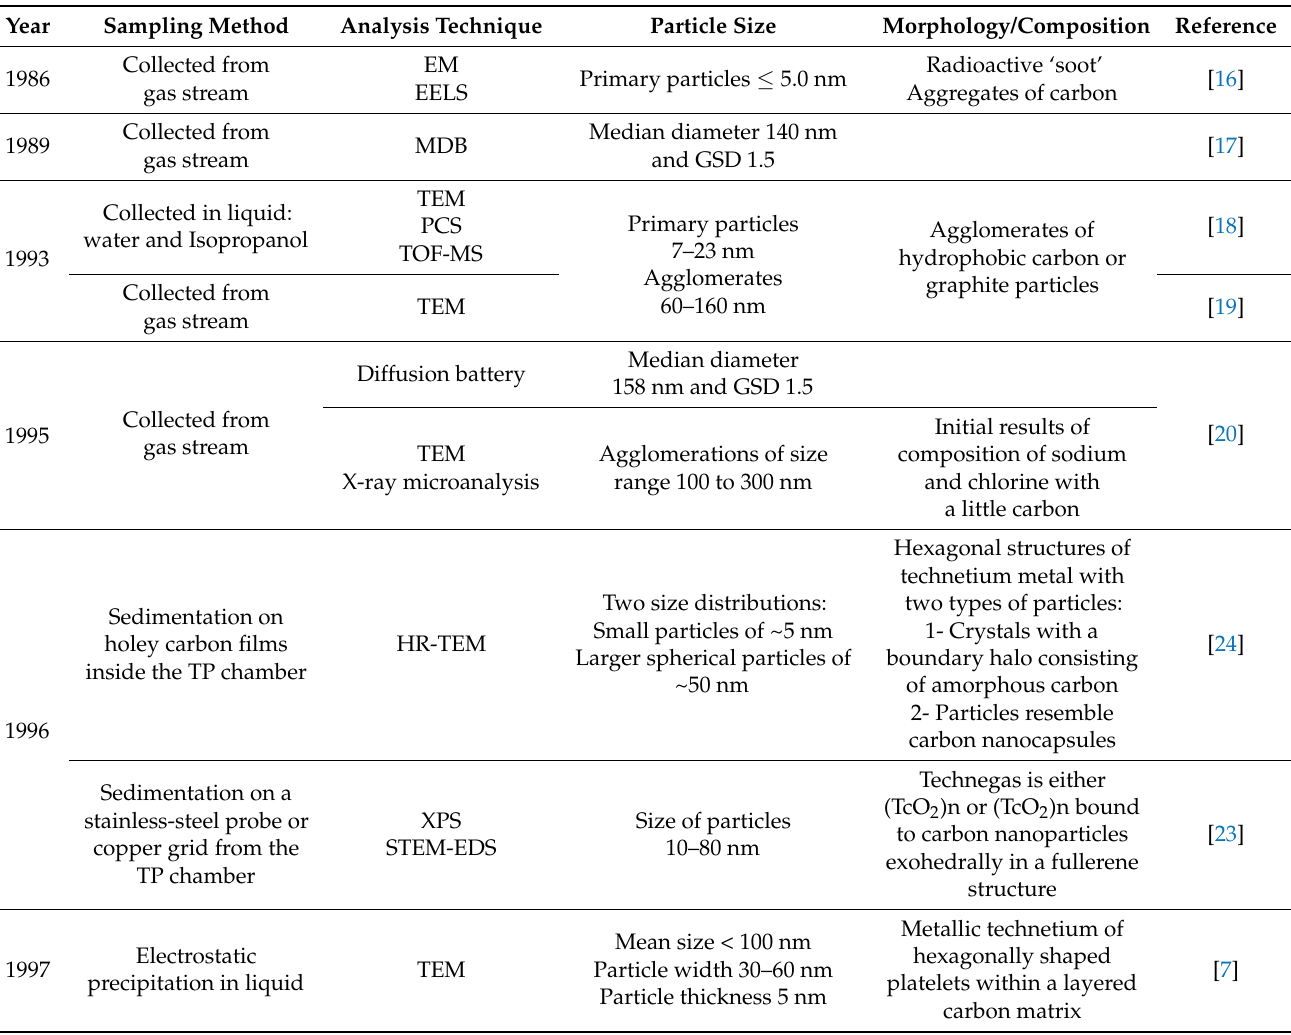
Table 1. Historical review of Technegas particle size and composition investigations using different sampling and analysis